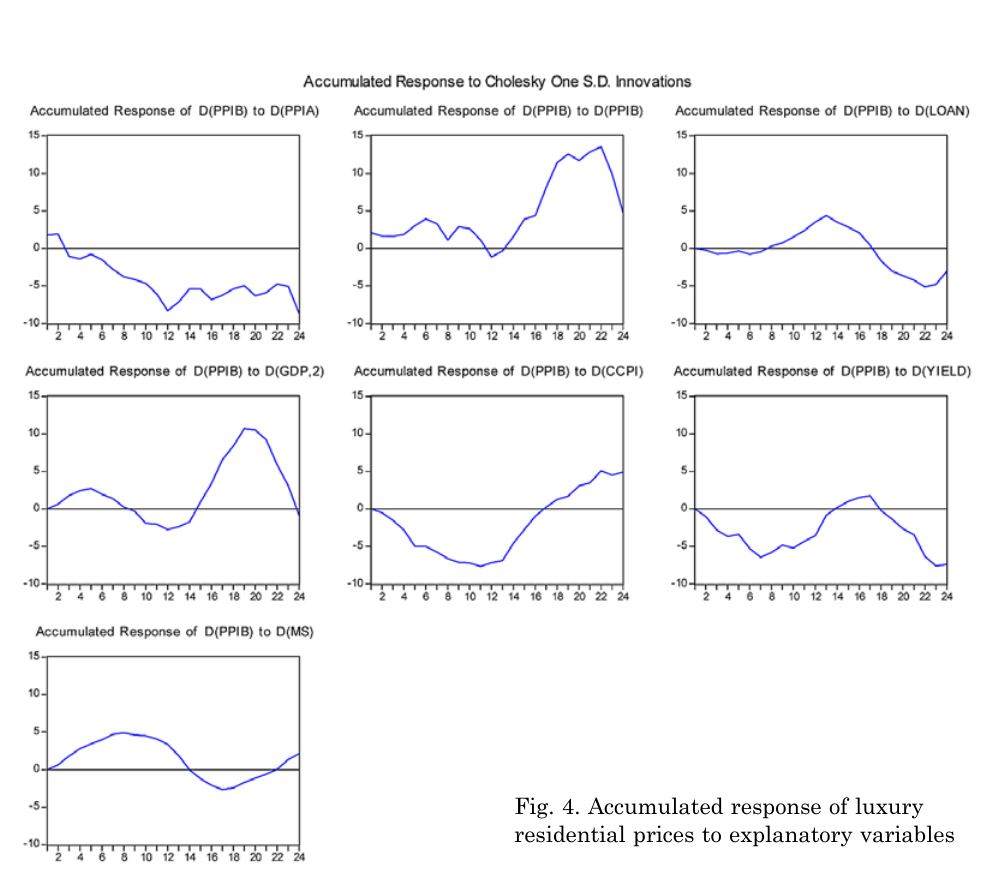
Fig. 3. Impulse response of luxury residential prices to explanatory variables